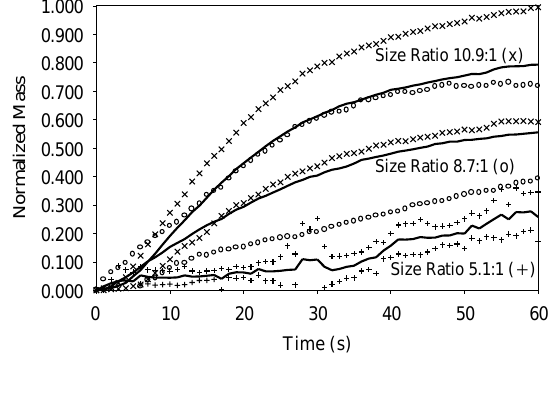
Fig. 9 Typical mass versus time relationships as a function of strain (cid:4) Size Ratio (cid:6) 10.9:1, Cycle Speed (cid:6) 0.75 cycles/sec- ond, Bed Depth (cid:6) 5.08